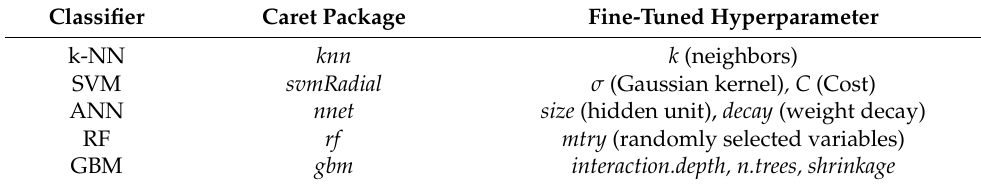
Table 1. Tuning hyperparameters in ML classifiers.